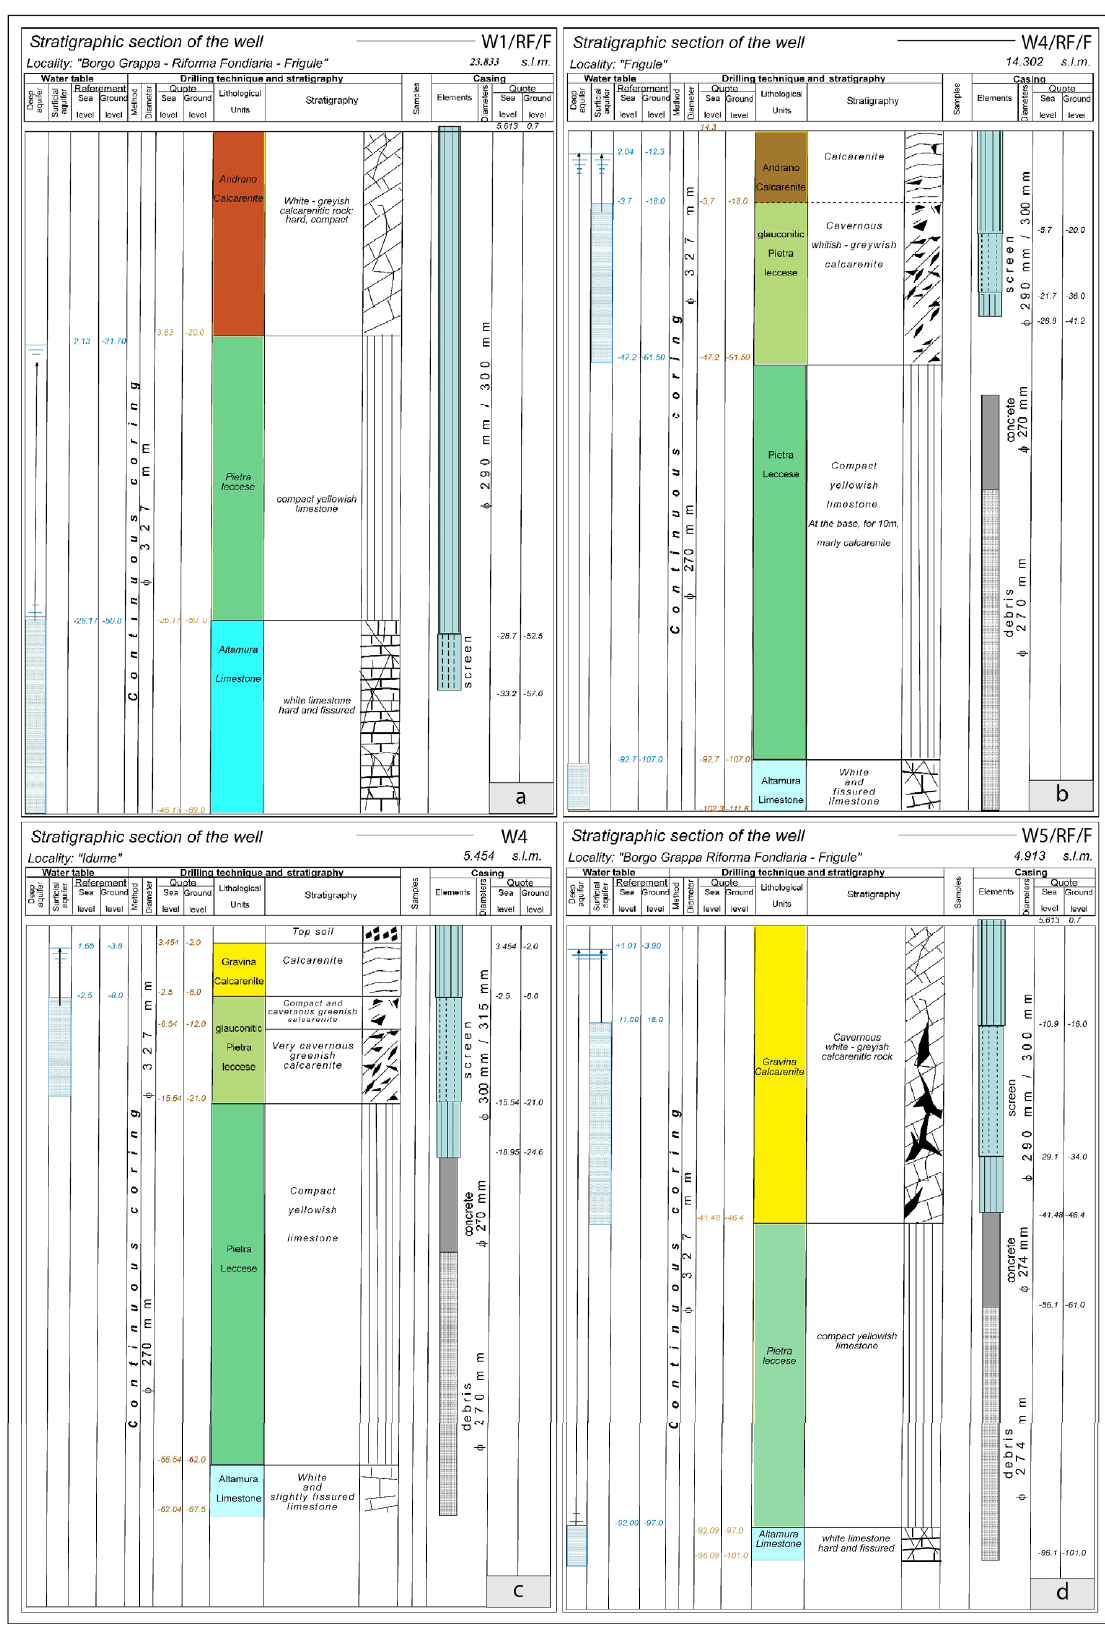
Figure 9. Stratigraphies in the Acquatina di Frigole area (data re-elaborated from the archive of Ente Irrigazione). Adapted from geological formations follows the work by Bossio et al. [114]. Borehole location is shown in Figure 8.